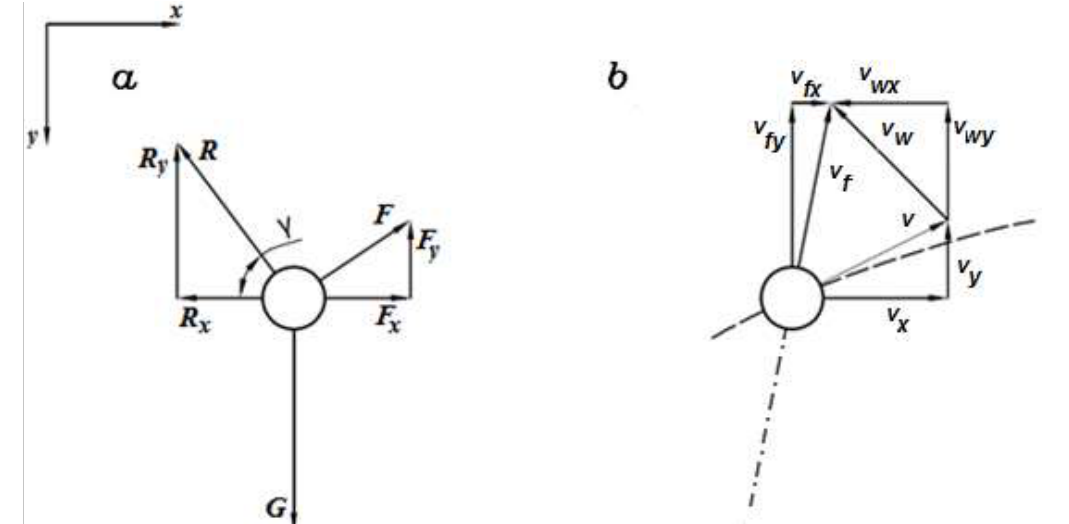
Figure 2. A particle in a stream of fluid shown in ( a ) a force diagram and ( b ) a velocity diagram. The dashed line denotes the particle trajectory. The dashed and dotted line is the direction of the fluid current.